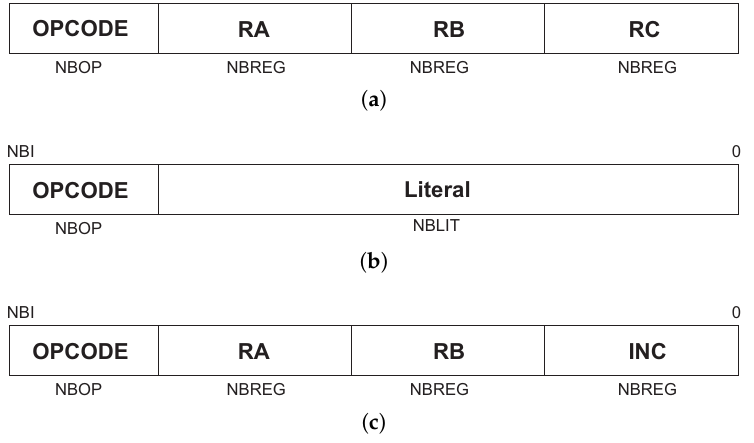
Figure 2. PAMPIUM instruction formats. ( a ) R Format. ( b ) L Format. ( c ) M